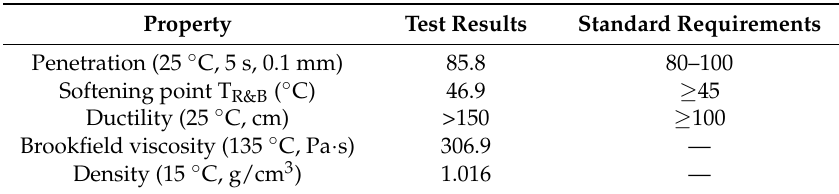
Table 1. Basic properties of bitumen.